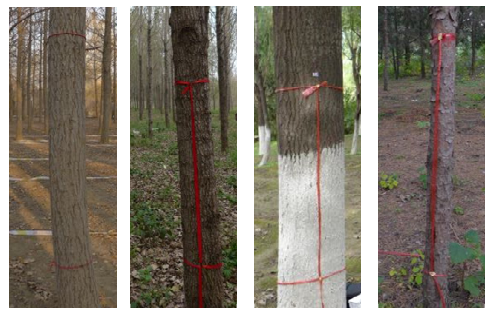
Figure 4. The marks for the spatial scale determination.